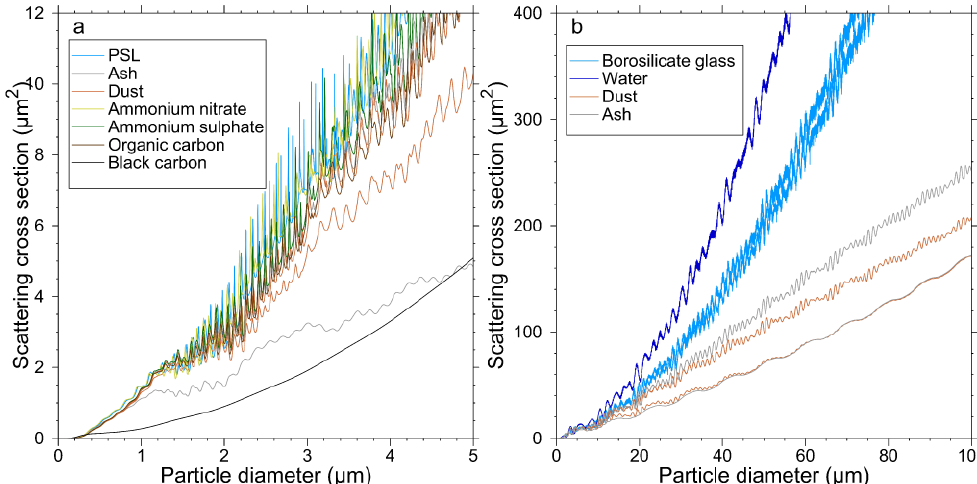
Fig. 1. Mie-Lorenz curves showing scattering cross sections for a variety of materials as measured by a PCASP (a) and a CDP (b) . Refractive indices are taken from Bond and Bergstrom (2006), Dinar et al. (2006, 2008), Highwood et al. (2011), Mu˜noz et al. (2004), Patterson (1981), Patterson et al. (1983), Toon et al. (1976), Wagner et al. (2012), Volten et al. (2001), Cook et al. (2007) and Weast (1966). The two curves for Saharan dust and volcanic ash approximately bound a range of refractive indices found in the literature. For borosilicate glass the two curves represent the two different refractive indices given by the manufacturer for different samples of calibration